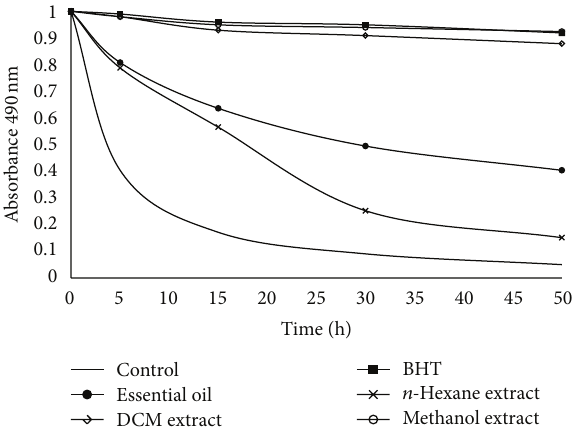
Figure 3: Antioxidant activity of M. longifolia essential oil and n -hexane, dichloromethane, and methanol extracts in terms of bleaching of 𝛽 -carotene-linoleic acid